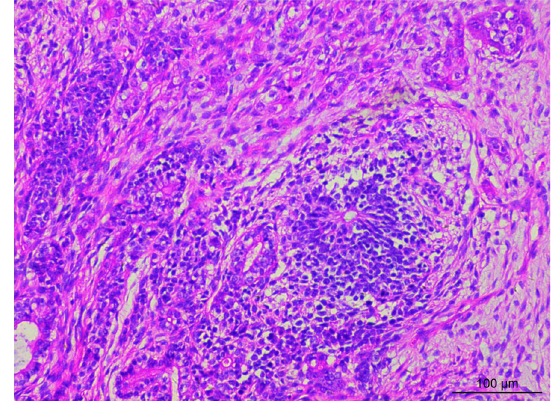
Fig. 3 H&E staining visualized at 200 tube, and daisy-shaped mass were found in tumor